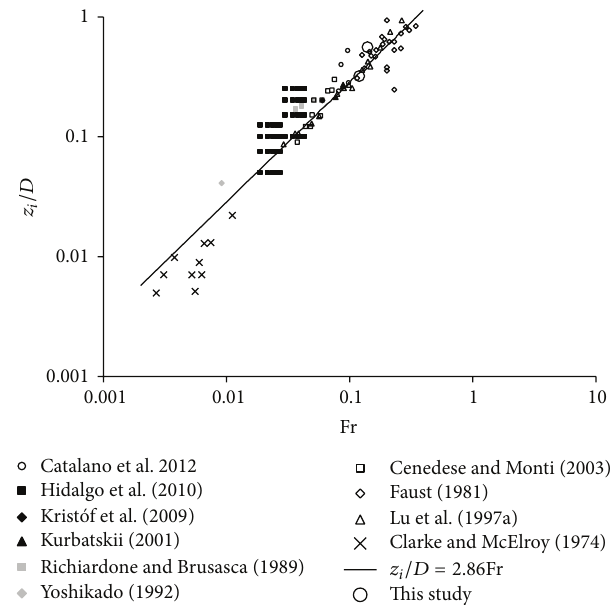
Figure 33: Ratio of mixing height to diameter (𝑧 𝑖 /𝐷) as a function of Fr for present laboratory results compared with literature data.